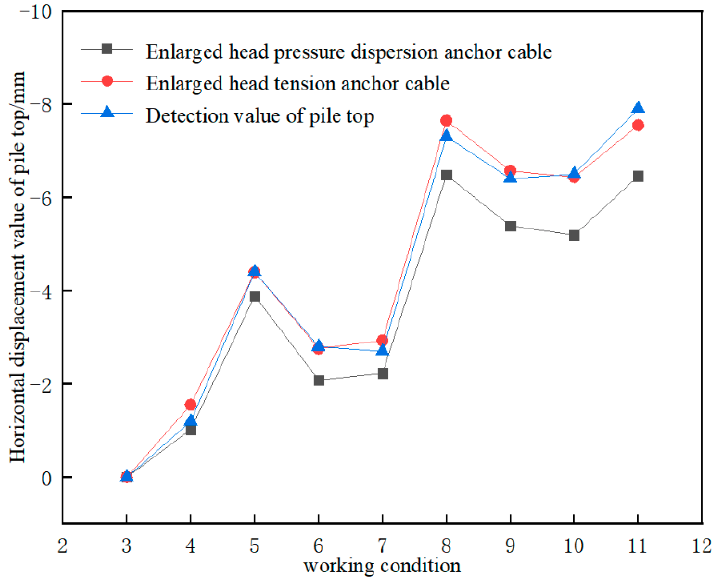
Figure 24. Changes in the horizontal displacement of the pile top under different working condi- tions.